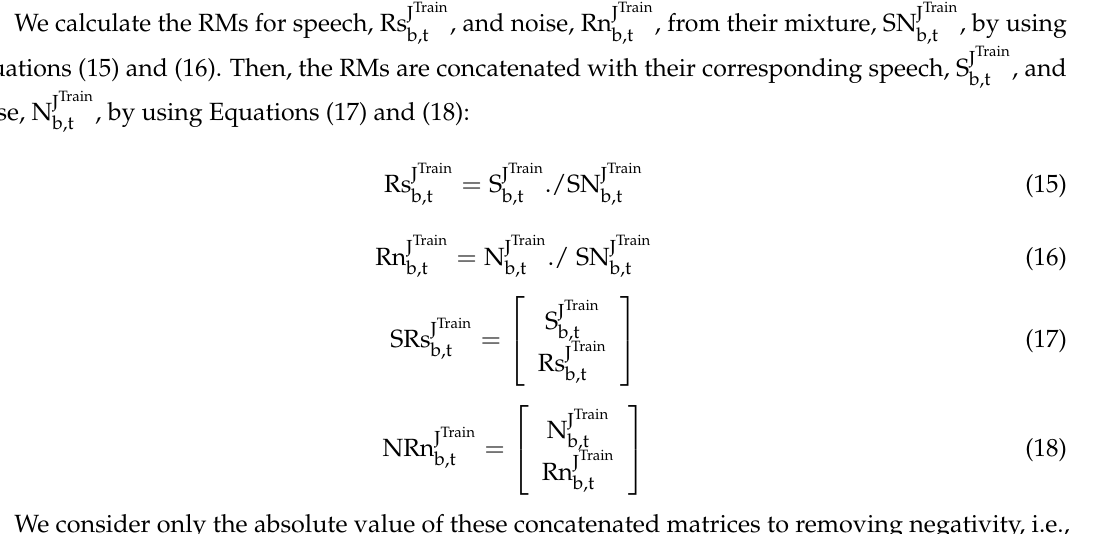
Figure 2. Block diagram of the proposed speech enhancement system.